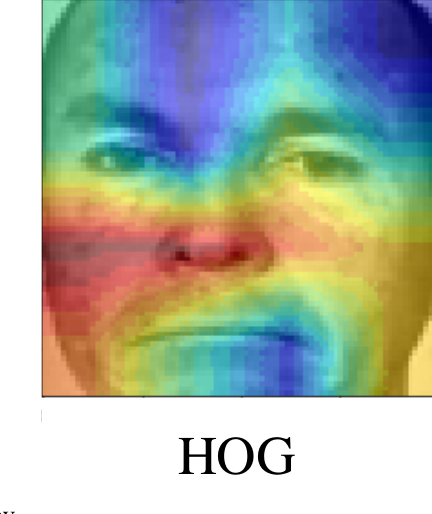
Figure 14. Most important zones of the faces for